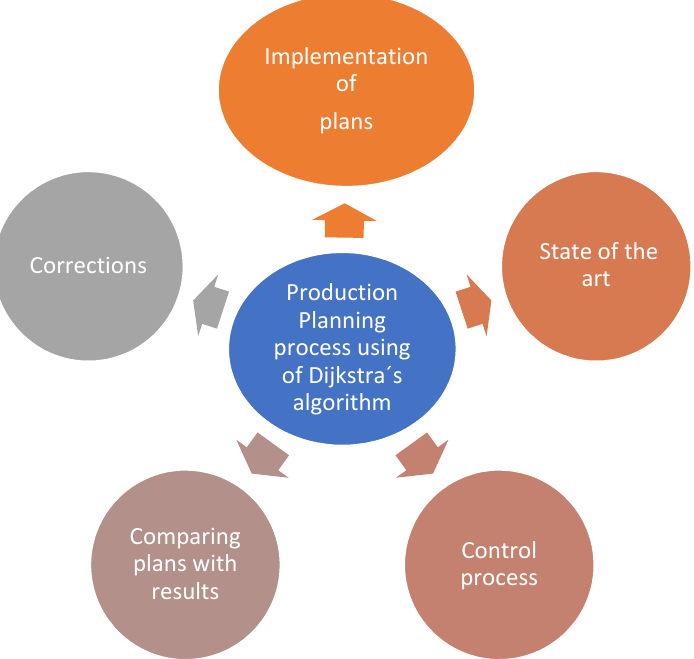
Figure 1. The relationship between important functions in the company management [Authors own processed].